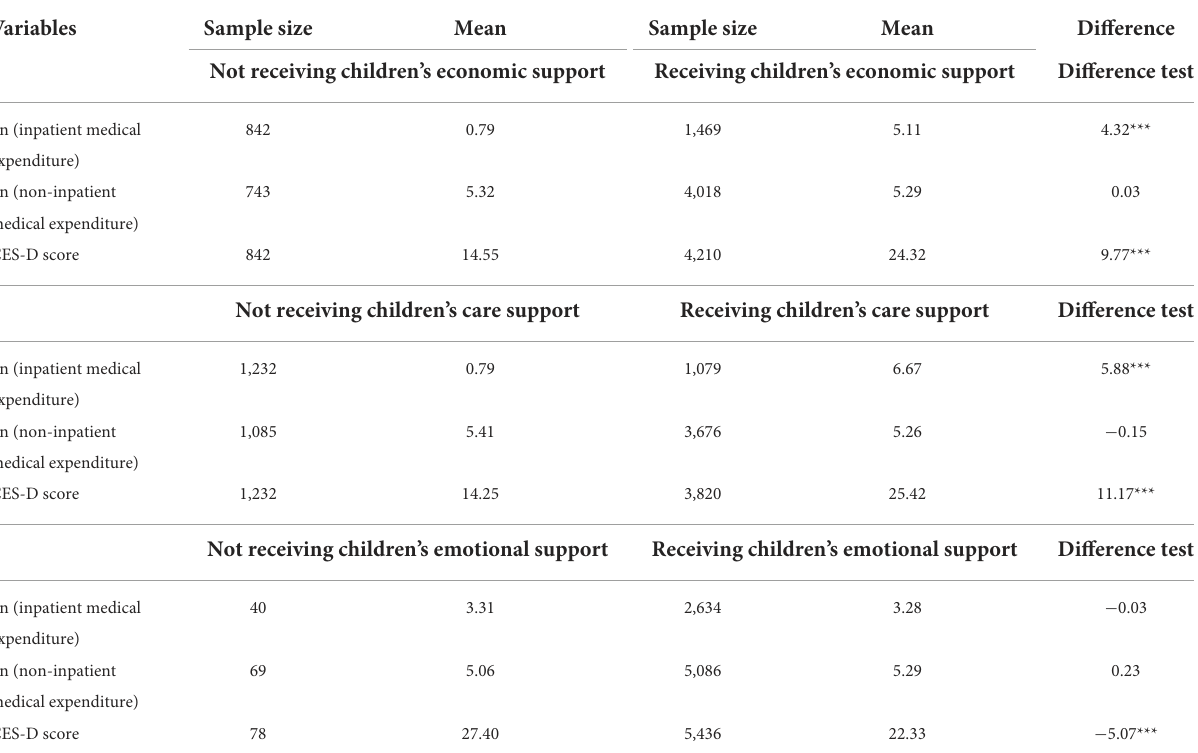
TABLE 2 Analysis of variance results of depression and medical expenditures among the rural elderly in the context of whether or not older adults received intergenerational